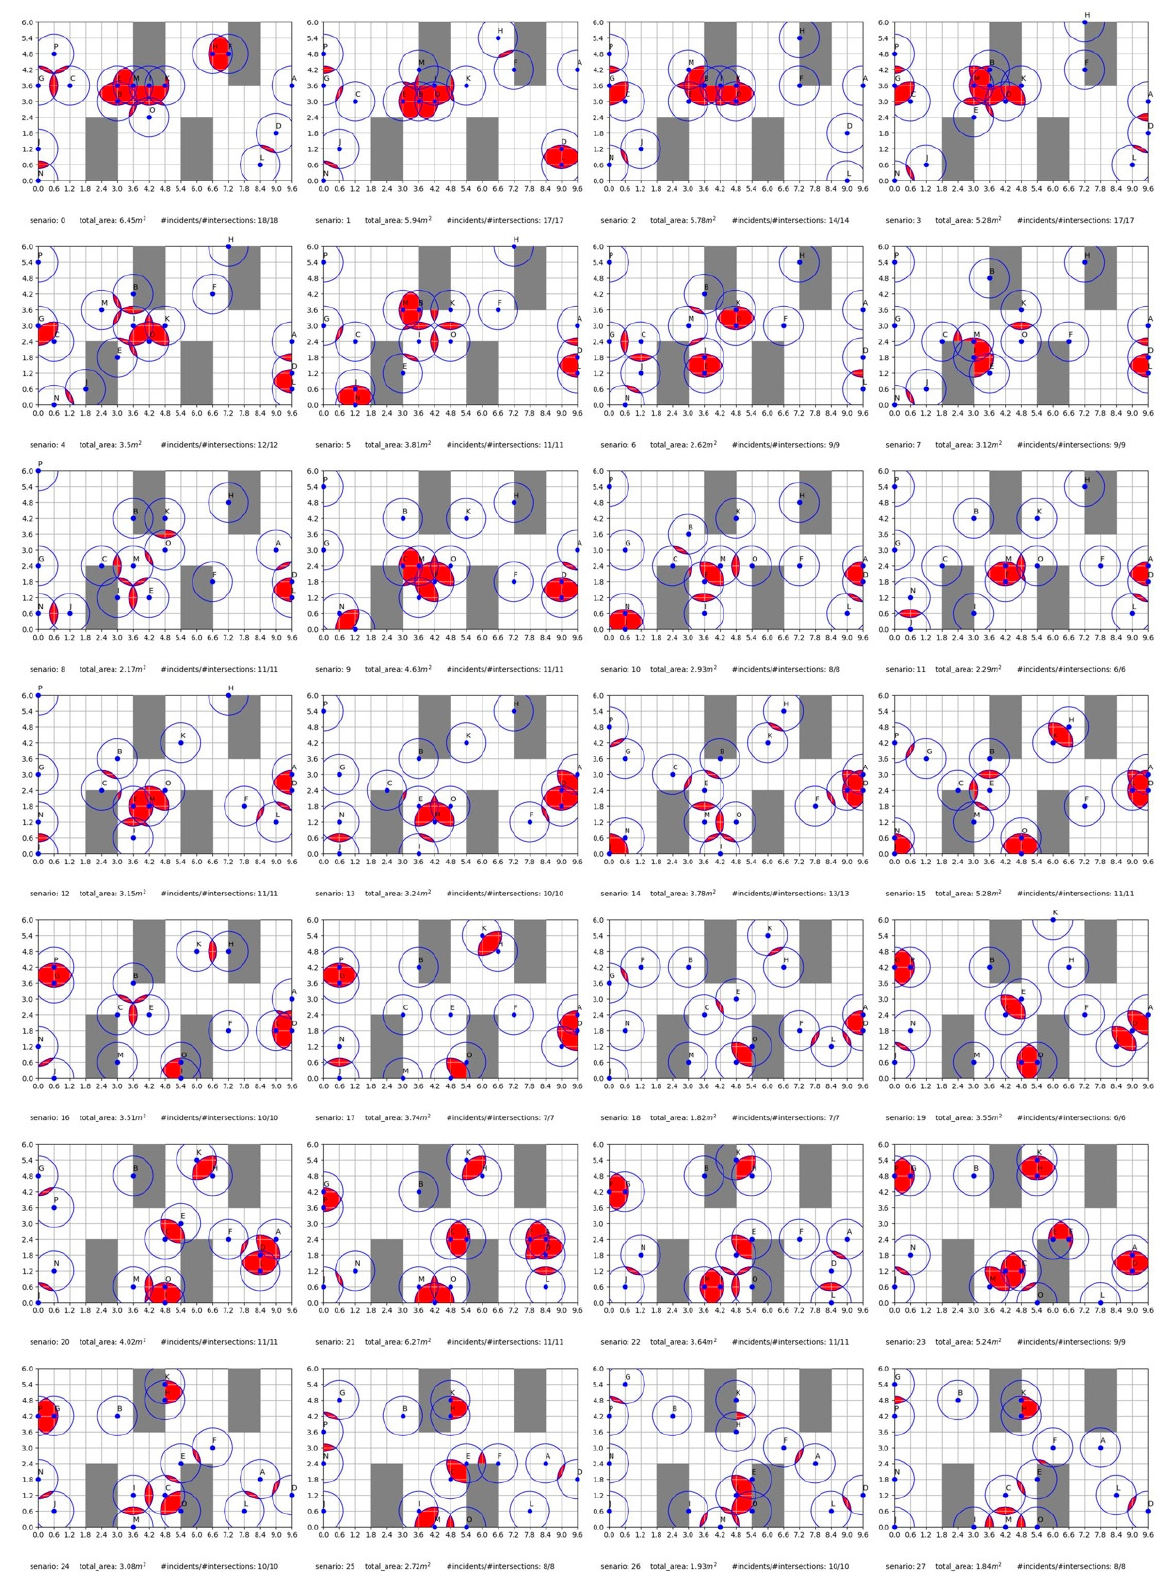
Figure 5. Graphic output showing simulated occupant positioning with the furniture layout for teaching and learning activity 3 (group work), without contact time consideration.